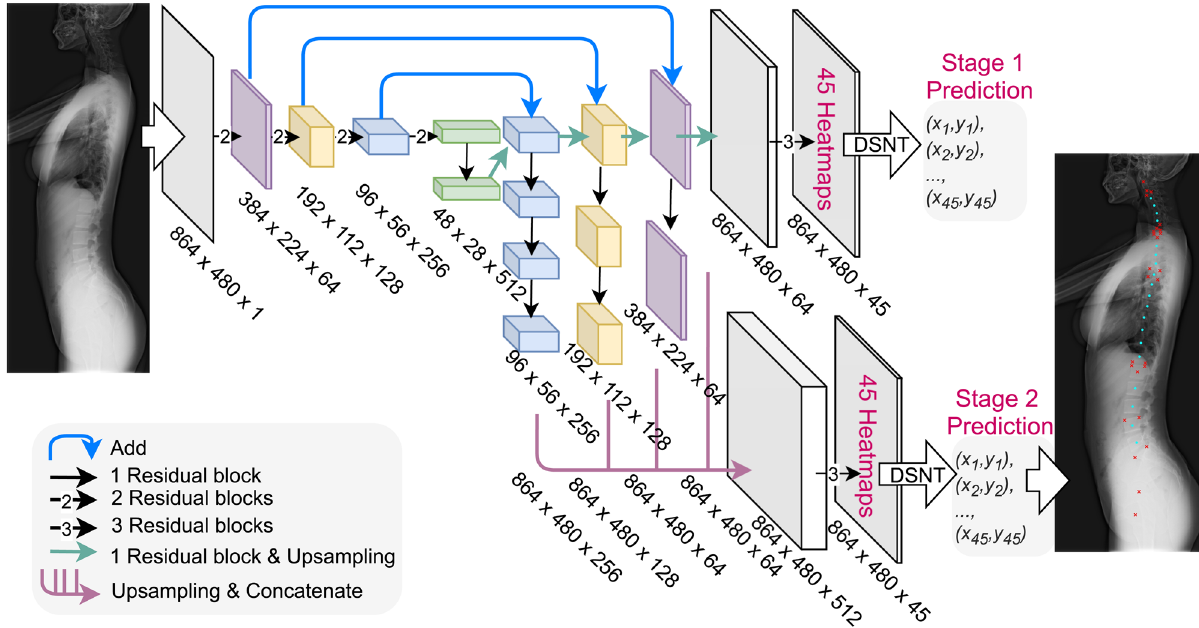
Figure 2. Model architecture. The radiographs were down-sampled to 864 × 480 px before being fed into the network. The network contained 25 trainable ‘residual blocks’. Each ‘residual block’ comprised two consecutive 3 × 3 convolutional layers if its input and output had the same shape (if not, an additional 1 × 1 convolutional layer was added to its skip-connection part). The network also contained three types of nontrainable blocks (‘Add’, ‘Concatenate’, and ‘Upsampling’), which were used for tensor addition, concatenation, and bilinear upsampling. The network had two stages. At the end of each stage, 45 landmark coordinates were predicted by applying ‘DSNT’ (illustrated in the Methods section) to the feature maps (heatmaps) of each landmark. In addition, the stage 1 prediction was an intermediate result used during training and discarded during